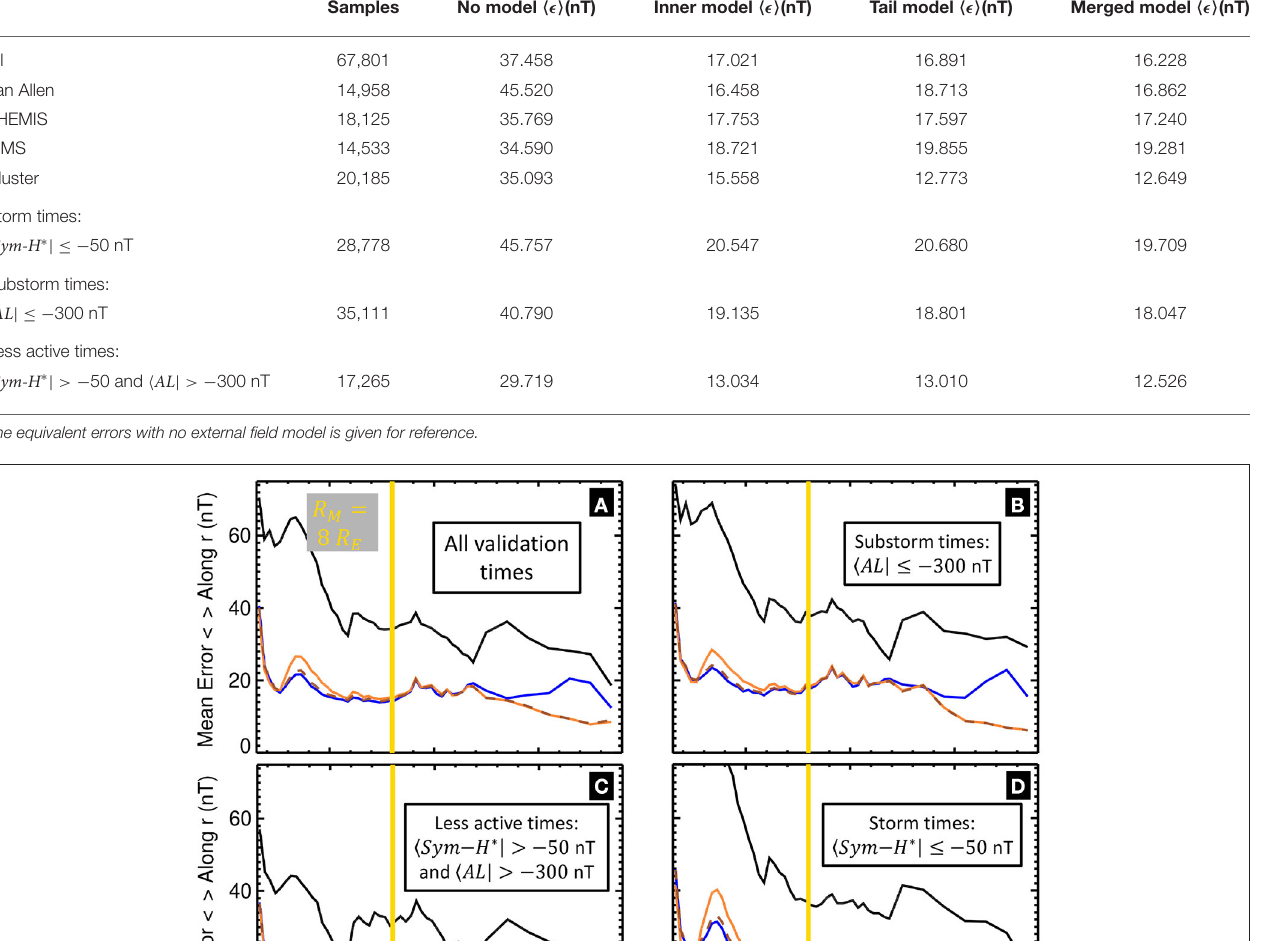
ǫ for the Inner , Tail , and Merged Models for different spacecraft and activity levels. h i Samples